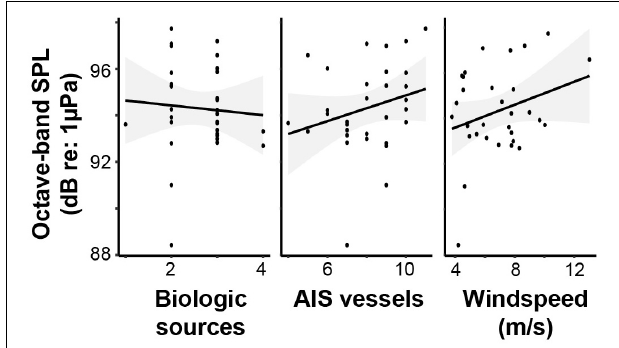
FIGURE 7 | Varying influence of soundscape components on sound levels. Daily measured sound levels in the 125-Hz octave band at a site in Stellwagen Bank National Marine Sanctuary (SB01) showed different relationships with number of biological sources (left) , Automatic Identification System (AIS) transmitting vessels (center) , and wind speed (right) . Linear relationships are shown for each component, fit using a linear model with standard error represented in the shaded area. While relationships are not significant, the trend of the relationship varies by presence of source. For the AIS transmitting vessels, data were summarized as the count of all unique vessels in a 10 km buffer around the acoustic sensor for each day. Wind speed was measured in m/s from a NOAA weather buoy 7 nautical miles away (station 44013, www.ndbc.noaa.gov) and averaged per day. Presence of biological sources was summarized from detected baleen whale calls (blue, fin, humpback, sei, and North Atlantic right whales) using Low Frequency Detection and Classification System (LFDCS) (Baumgartner and Mussoline, 2011) and Atlantic cod grunts using automatic grunt detector and recognizer for Atlantic cod (Urazghildiiev and Van Parijs, 2016). The same 31 days are shown in each panel.